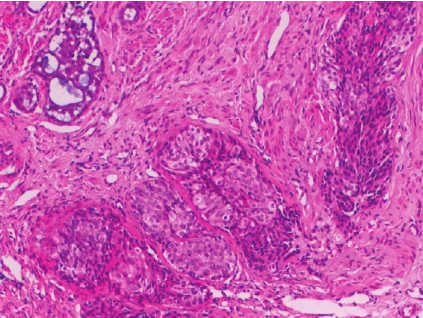
Figure 1: Photomicrograph of biopsy specimen of Case 1, showing the squamous cell carcinoma component (middle) and the adenoid cystic carcinoma component (upper left) (Hematoxylin and Eosin × 100).